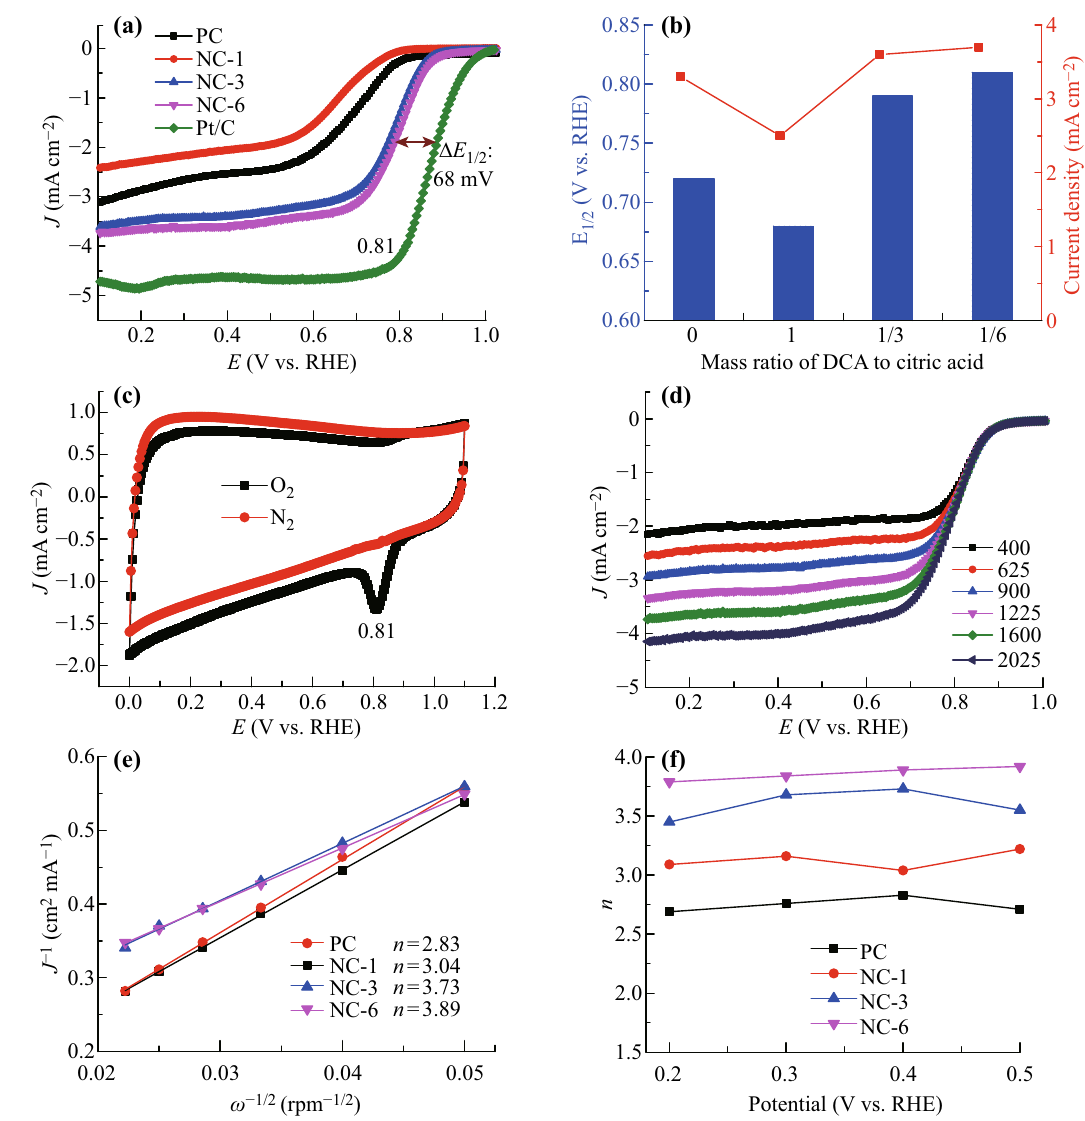
Fig. 6 Electrochemical oxygen reduction measurements in 0.1 M KOH solution. a Comparison of LSV curves for PC, NC-1, NC-3, NC-6, and commercial Pt/C catalyst at a scan rate of 10 mV s - 1 and 1600 rpm in O 2 -saturated solution. b Dependence of half-wave potential ( E half ) and current density on the mass ratio of dicyanamide (DCA) to citric acid. c CV curves of NC-6 in O 2 - or N 2 -saturated solution. d LSV curves of NC- 6 and Pt/C at different rotation speeds (varying from 400 to 2025 rpm). e K – L plots of the samples based on the LSV curves at different rotation speeds and 0.4 V (vs. RHE). f Electron transfer number ( n ) calculated from the K – L plots of the various samples in the potential range of 0.2–0.5 V (vs.